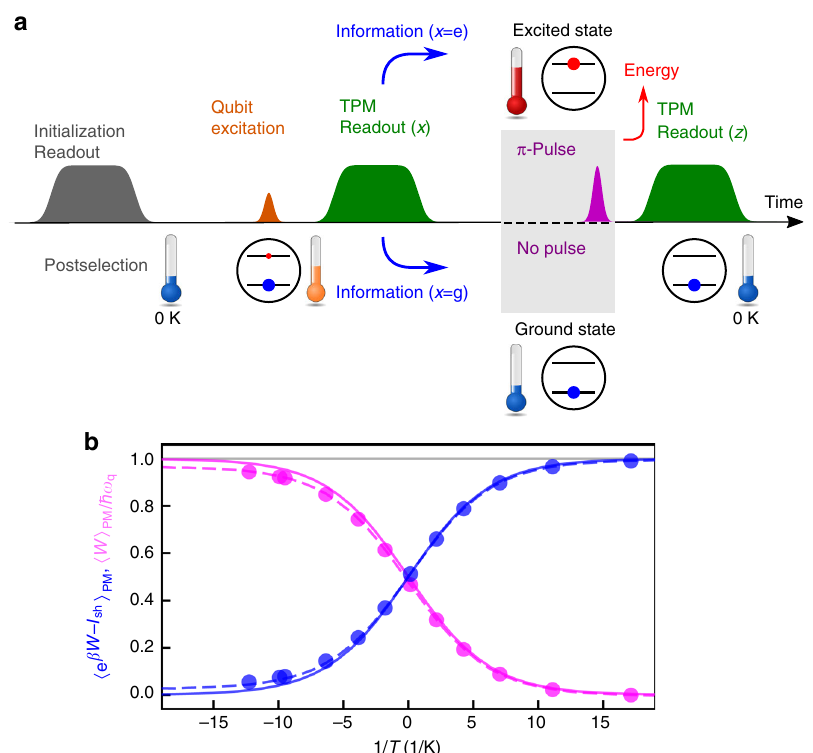
Fig. 2 Generalized integral fl uctuation theorem under feedback control. a Pulse sequence used in the experiment. The qubit is initialized with a projective measurement and postselection, followed by a resonant pulse excitation which prepares the qubit in a superposition state as an input. The two-point measurement protocol (TPM) involves two quantum non-demolition projective readout pulses. Depending on the outcome x of the fi rst readout ( x = g or e corresponding to the ground or the excited state of the qubit), a π -pulse for the feedback control is or is not applied. The π -pulse fl ips the qubit state to the ground state and extracts energy. The second readout with outcome z completes the protocol. See the Supplementary Note 2 for details. b Experimentally (cid:1) obtained statistical averages e β W (cid:1) I Sh (gray solid line) is the theoretical value of the probability 1 − λ fb in the presence (absence) of absolute irreversibility. The magenta solid curve is the expectation value of the normalized extracted work. The corresponding blue and magenta dashed curves are obtained by a master equation, which